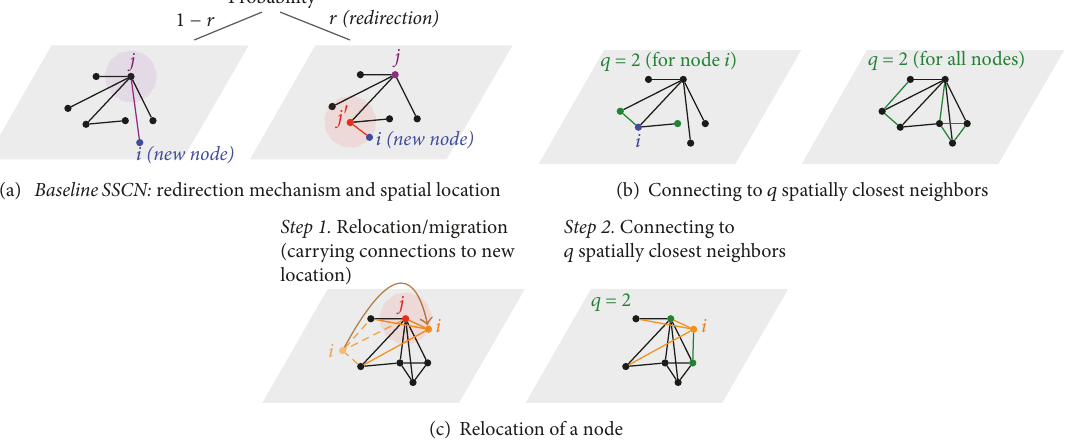
Figure 1: Growth rules for the baseline (a) and the revised SSCN model (b & c). (a) A new node 𝑖 joins the network and connects directly to a randomly selected node 𝑗 , with probability 1−𝑟 , settling away from 𝑗 according to the rule of (2) (left panel). With probability 𝑟 the connection is redirected to a random neighbor 𝑗 󸀠 of 𝑗 and 𝑖 settles at distance 1 from 𝑗 󸀠 (right panel). (b) Befriending 𝑞 closest neighbors (shown for 𝑞 = 2 ). Left panel: Node 𝑖 needs to add a connection to the nearby node on its left, in order to fulfill the requirement of connections to at least 𝑞 nearest neighbors. The new link and 𝑖 ’s 2 nearest friends are highlighted in green. Right: The process is repeated for all nodes in the network until all fulfill the minimum- 𝑞 requirement. The new links added to the baseline model are highlighted in green. (c) Relocation of node 𝑖 happens in two stages. Left: In the first stage 𝑖 is translated to within distance 1 from a randomly selected node 𝑗 . All of 𝑖 ’s old contacts (broken orange lines) are retained (orange lines). Right: In the second stage links are added to ensure connection to at least 𝑞 new closest neighbors of 𝑖 (shown for 𝑞 = 2 ). A new link and the 2 closest neighbors are highlighted in green. Note that relocation does not alter the connectivity pattern in step 1, but the relocating node 𝑖 may acquire up to 𝑞 new links in step